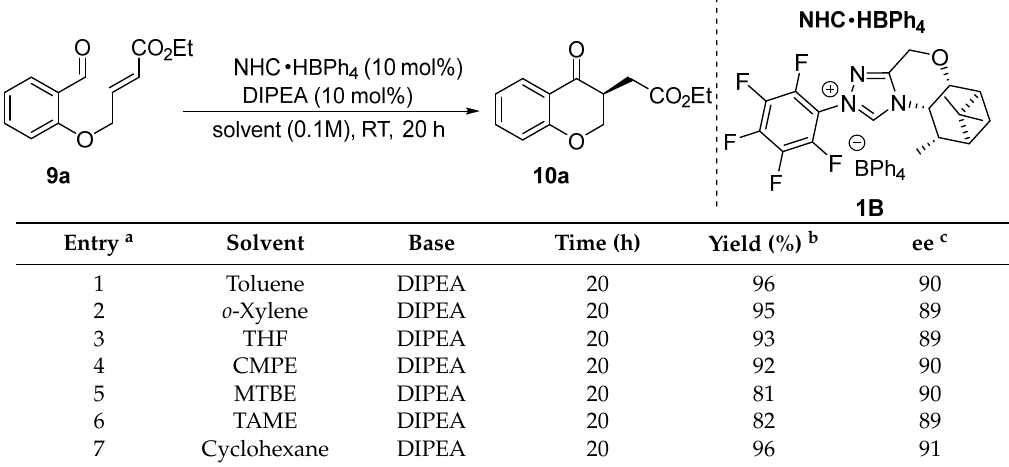
Table 3. Screening of solvents.